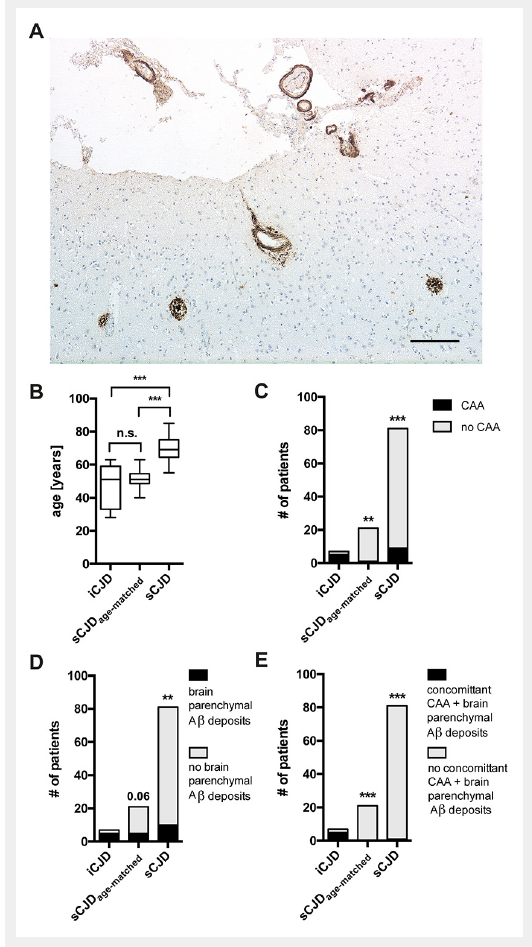
A: Immunohistochemistry for Aβ demonstrates prominent deposits (brown) in vessel walls and plaques in frontal cortex of iatrogenic CJD (iCJD) case (age 33 years). Scale bar = 200 μm. B–E: Statistical comparisons of iCJD, age-matched sporadic CJD (sCJD) and non-age-matched sCJD for age (B), cerebral amyloid angiopathy (CAA) (C), brain parenchymal deposits (D), and concomitant CAA and brain deposits (E). B: Bars are median + 25%/75% percentile (box) and min/max (whiskers). ** p <0.01, *** p <0.001.